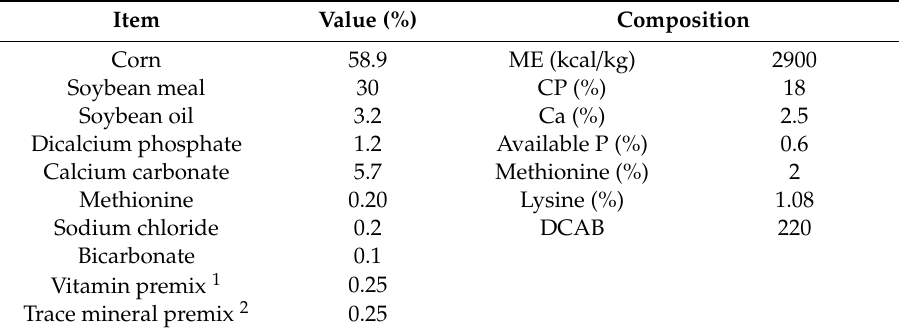
Table 1. Ingredient and composition of the basal